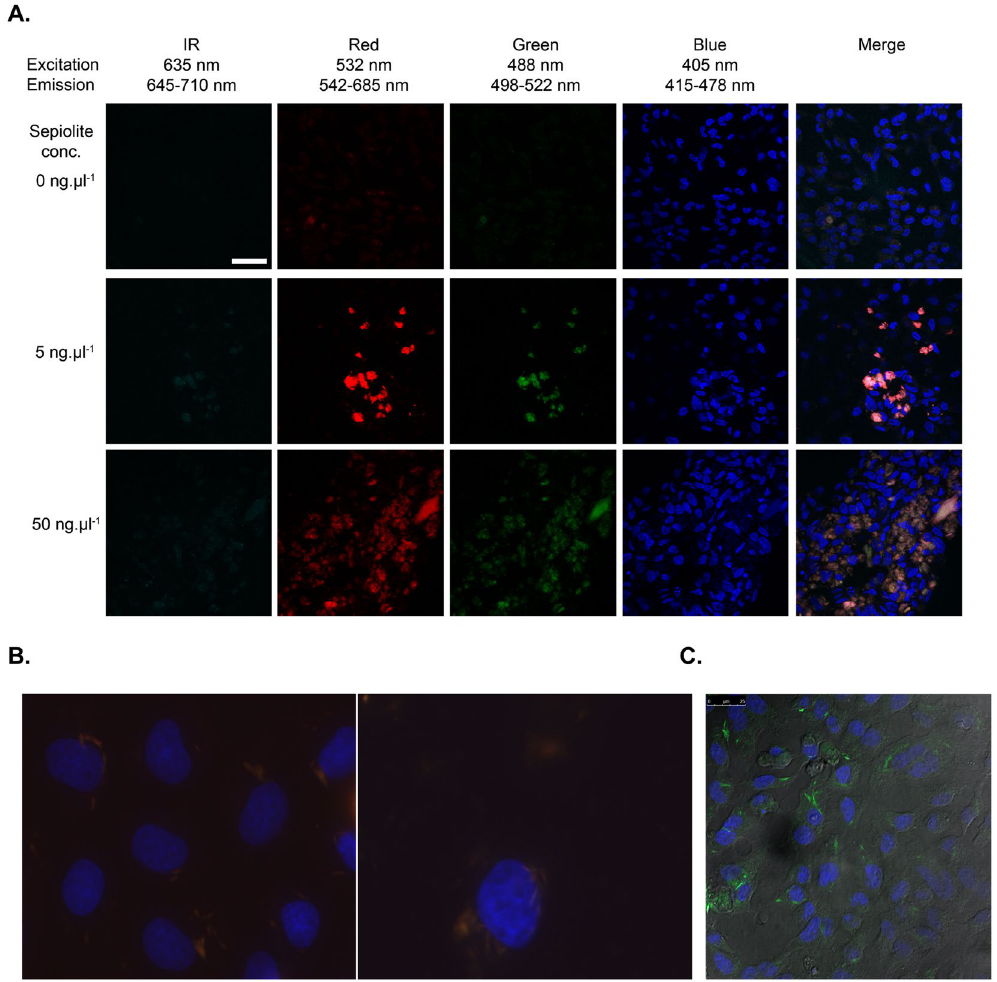
Figure 1. Laser confocal microscopy images of sepiolite fibers (0, 5 and 50 ng· μ l − 1 ) in V79 cells. ( A ) Channels: IR (infrared), red, green and blue, at given excitation and emission wavelengths. Sepiolite has a natural fluorescence in the green and red ranges and is not fluorescent in blue or infrared. The blue fluorescence represents the Dako-DAPI staining of the cell nuclei. In merged images, we confirmed that sepiolite fibers were uptaken by the cells. IR: infrared. The sepiolite concentration is indicated on the figure. The wavelengths of excitation (Exc) and fluorescence emission (Emis) are indicated. ( B ) Magnified fluorescence microscopy images of sepiolite fibers in V79 cells. Nucleus in blue (DAPI staining), sepiolite fibers in orange/red. ( C ) Phase contrast in confocal analysis visualizing cell contour and the presence of sepiolite (green) inside the